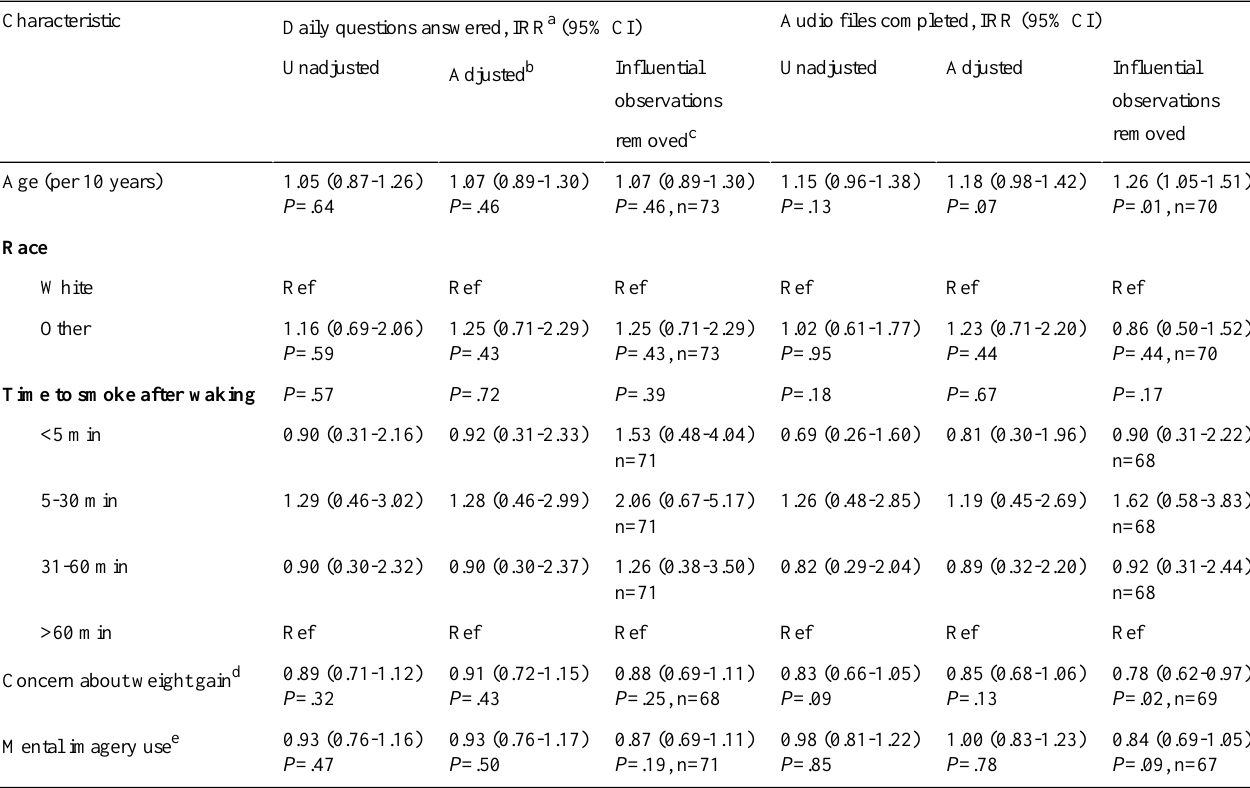
Table 3. Associations between baseline characteristics and usage outcomes. App-based analytics for full trial participants (n=73) over the study period, as incidence rate ratios (IRR); results of sensitivity analysis, where influential observations are removed, are